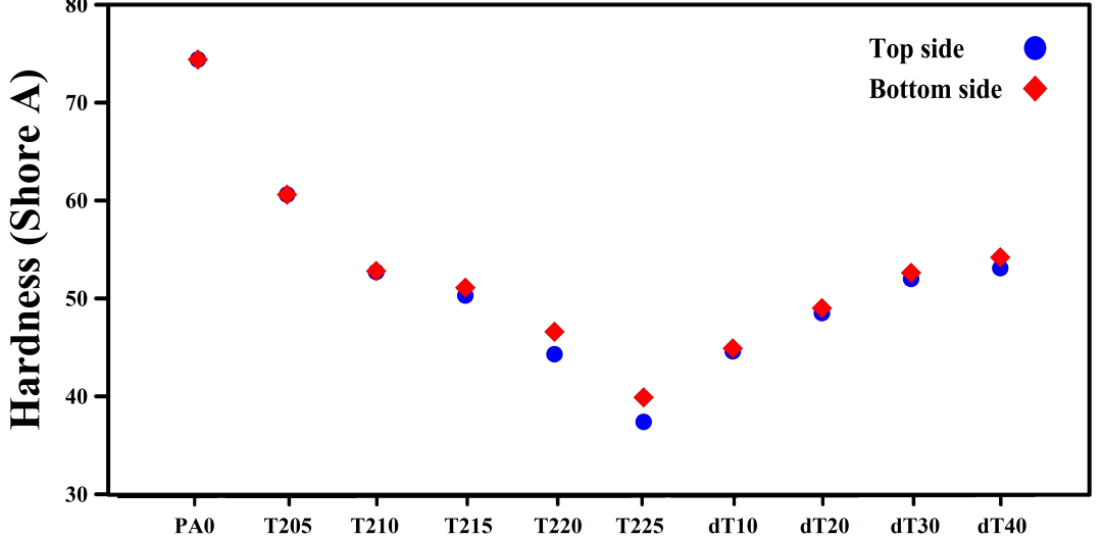
Figure 5. Hardness of unfoamed, uniform and graded POE foams (top and bottom sides).